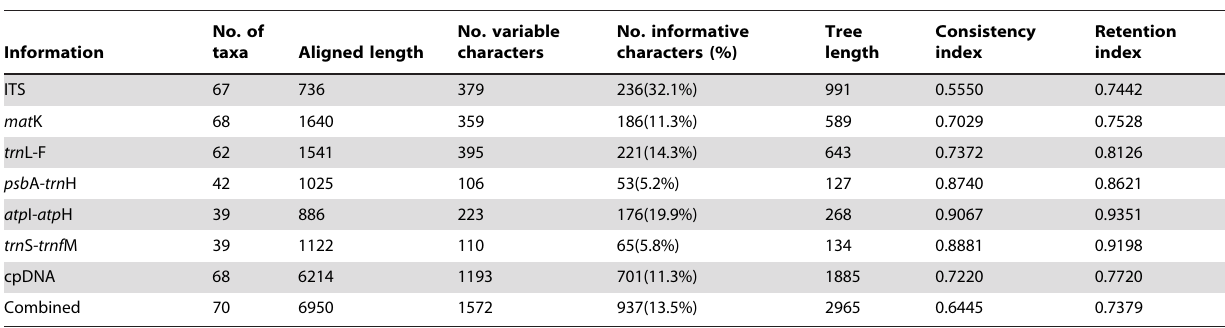
Table 1. Statistics from the analysis datasets.